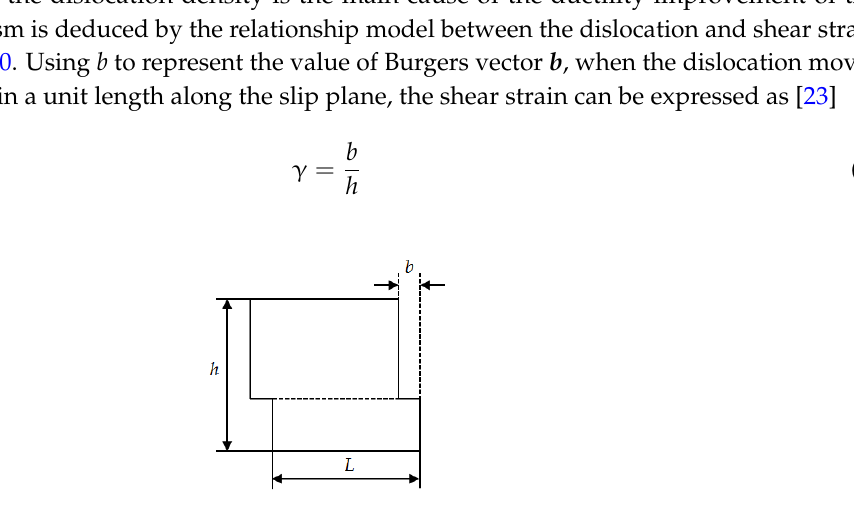
Figure 9. Frank-Read dislocation multiplication [22]: ( a )–( e ) the process of dislocation multiplication.